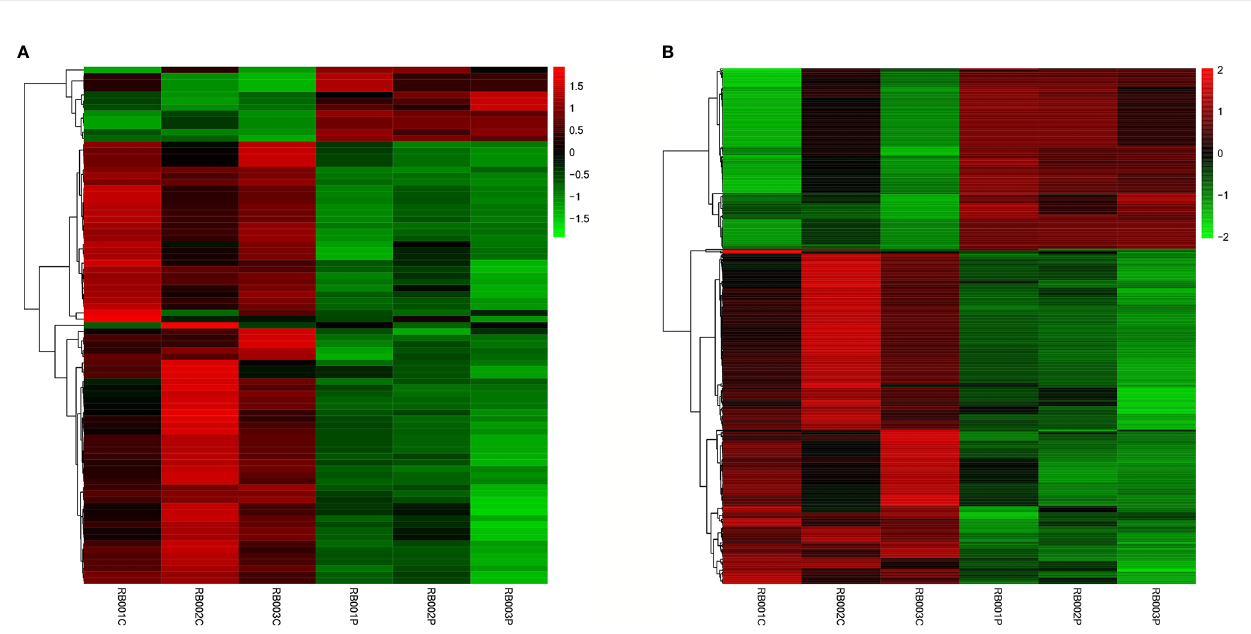
FIGURE 1 | Expression pro fi les of differentially expressed lncRNAs and mRNAs in PCOS patients and normal subjects. The hierarchical cluster analysis generated heat maps of differentially expressed lncRNAs and mRNAs (log2 fold change > 2; q < 0.05). Color represents the log10 (RPKM + 1) value, with red indicating upregulated genes and green indicating downregulated genes. (A) lncRNA; (B)